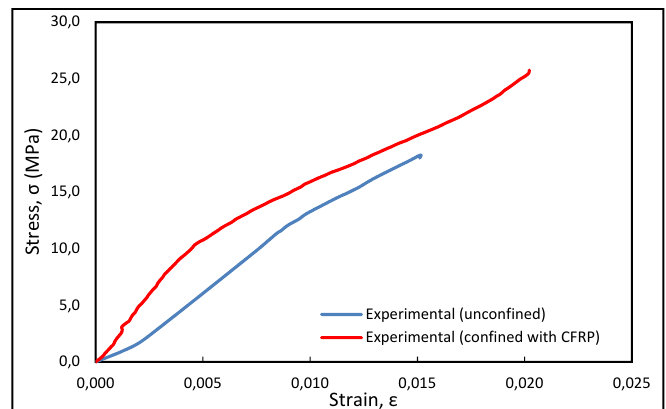
Figure 5. Stress-strain relationship of circular hollow unconfined and confined RC column with CFRP under full axial load.